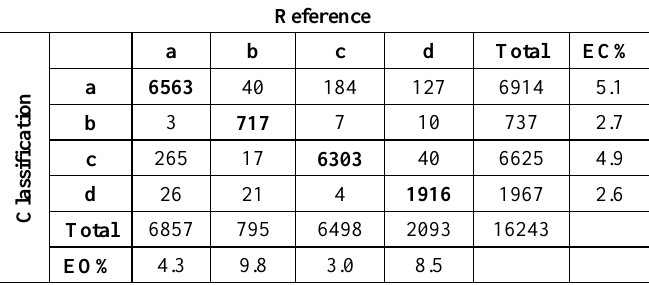
Table 1. Confusion matrix: (a) Perennial crop, (b) Annual crop, (c) Planted Forest and (d) Semi-perennial crop. EC = errors